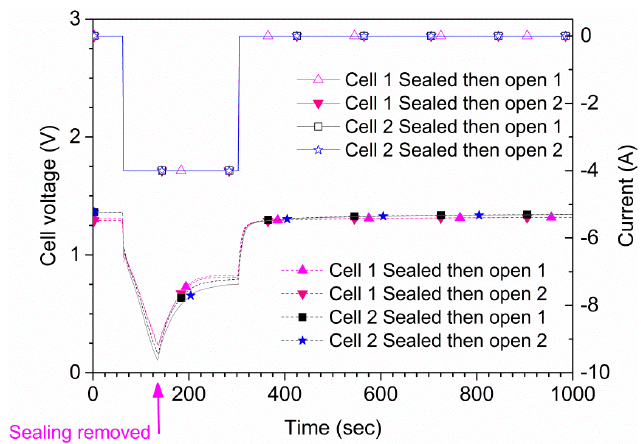
Figure 5. Voltage (filled symbols) and current (open symbols) measurements for sealed then open, for two repetitions per cell and for two different cells, cells 1 and 2.